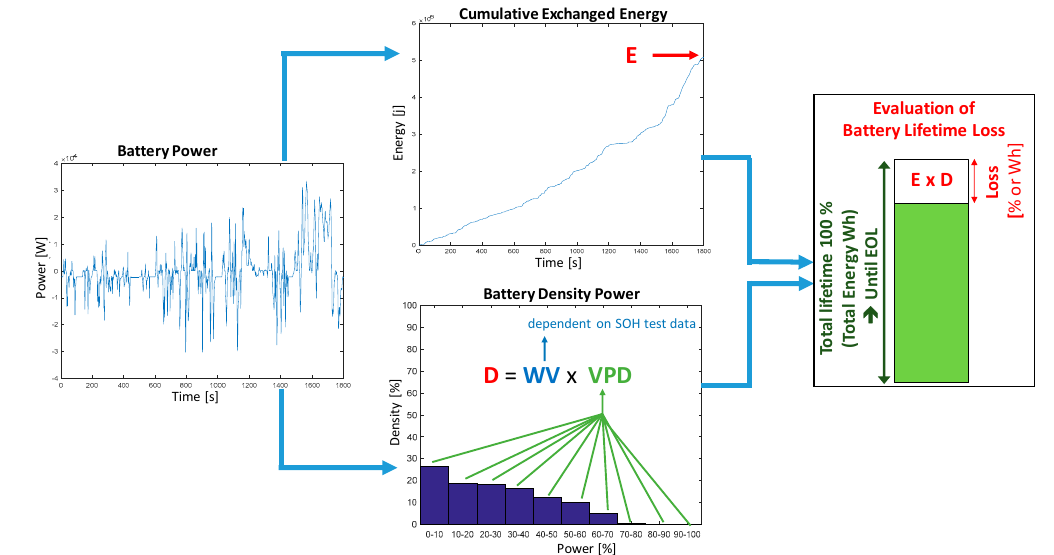
Figure 8. Reliability assessment approach.